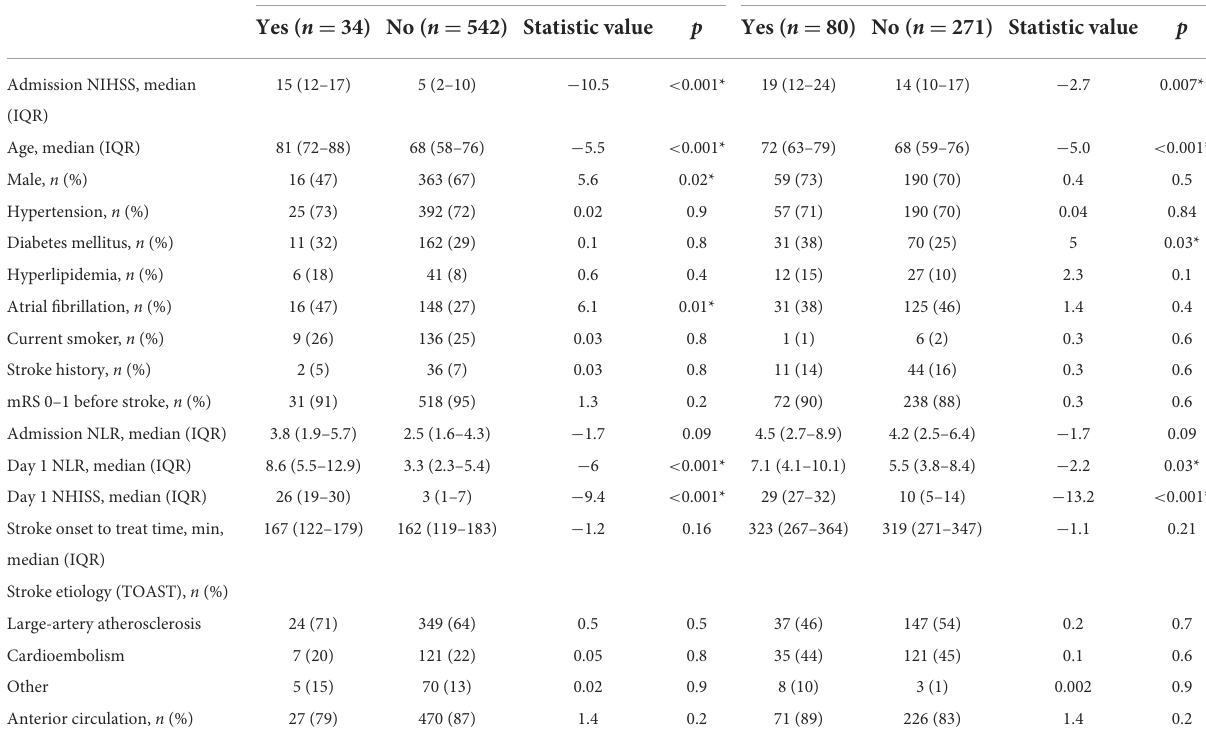
TABLE 4 Comparison of clinical characteristics and NLR in patients presented 90 death or